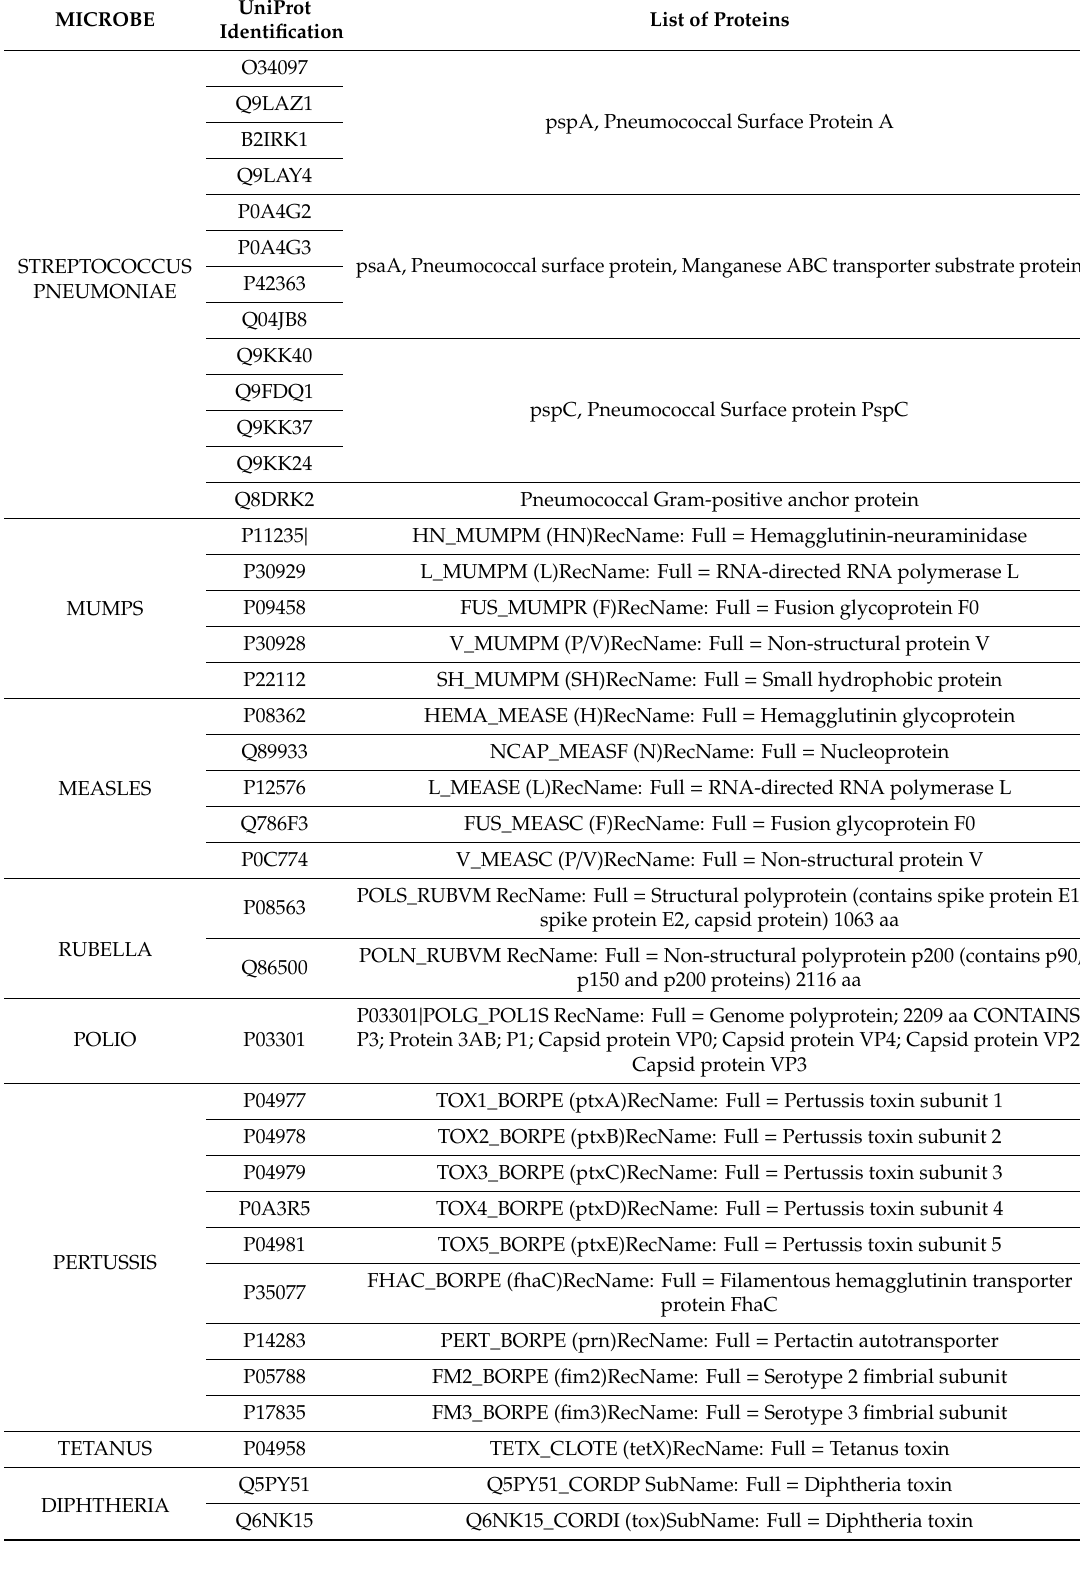
Table 1. UniProtKB accession numbers for viral and bacterial proteins used in this study.